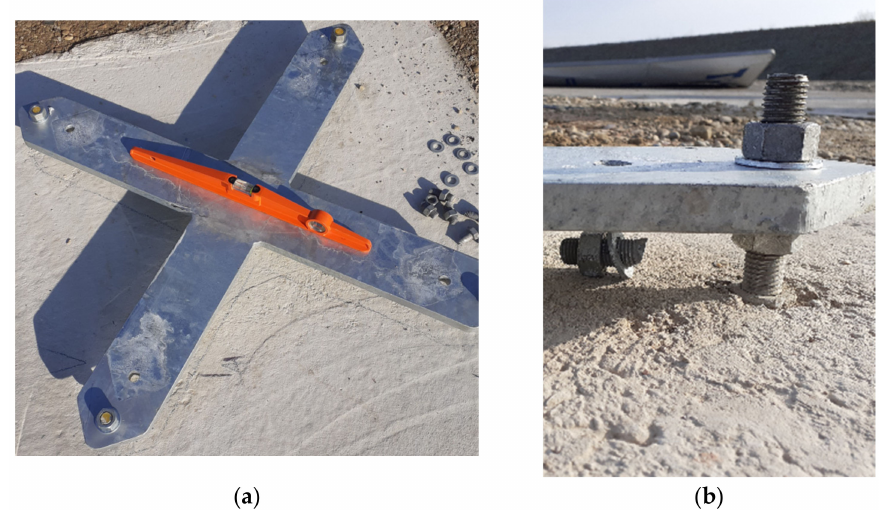
Figure 10. Mast base plate ( a ) and anchors after the experiment ( b ). As the column was separated from the base anchored in the foundation, the mast column, as a result of an impact, rotated around the center of gravity and moved above the traveling vehicle. In the case of the test with lower velocity, the column leaned against the vehicle roof and then slid down without a complete vehicle stoppage. The results of experimental tests were presented in the form of sequential images taken by a fast camera. Figure 11 shows the result of a crash test of a vehicle with a T03 mast at 35 km/h velocities. At the moment of 0.0 s the vehicle contacted the column of the tested mast; at 0.1 s a process of destruction of joints commenced as a result of which at 0.3 s the column was completely separated from its foundation and began to rotate about its center of gravity above the vehicle. At 1.9 s the mast column fell down after the traveling test vehicle. A mechanism of separation of the mast column from its foundation for each of the tested structures was identical.